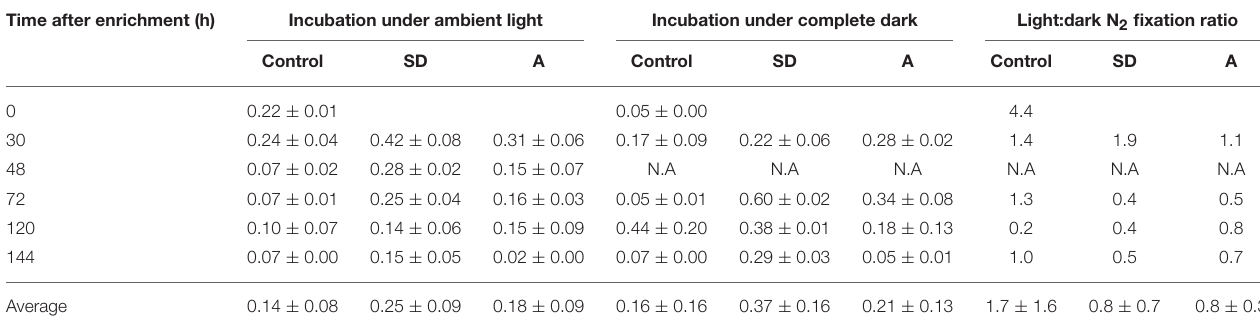
Values are averages of 3 independent replicates. The time 0 measurement is an average of 3 randomly picked mesocosms. N.A, not available.